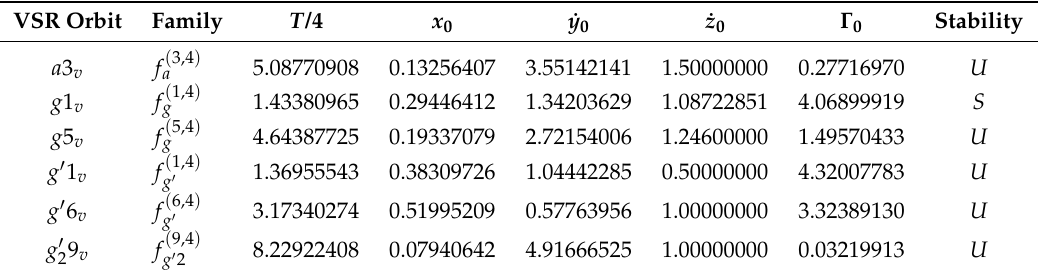
Table 4. Sample members of families of 3D periodic orbits having the O x − O xz double symmetry. These families bifurcate from the VSR orbits presented in the first column. The last column indicates whether each family contains stable parts ( S ) or not ( U ) .